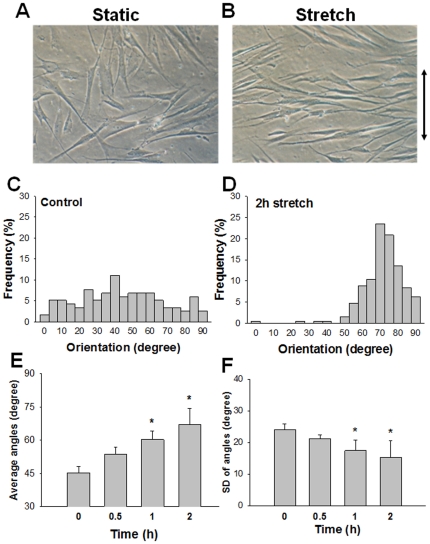
Effects of cyclic stretch on cell reorientation.Phase-contrast images of the cells in the static condition (A) or in response to cyclic stretch (20% in strain, 30 cycle/min) (B). An arrow indicates stretch direction. Histograms of the orientation response of the cells in the static condition (C) or to 2 h uniaxial cyclic stretch (D). Images of the unstretched and stretched cells were obtained at 0.5 h, 1 h, and 2 h after the onset of cell stretching. After the cell angles were measured, the angles were binned into 19 groups for every 5°: 0°, 1–5°, 6–10°, …, 81–85°, and 86–90° (C and D). Total cell number (frequency) was set as 100% and the frequency in each group was expressed relative to the total cell number. (E and F) The mean and standard deviation (SD) of the cell orientation at each time point. The decreasing SD of angles indicates that the cells were aligning in a direction which was almost perpendicular to the direction of applied stretch. Bar graph represents means ± SD (across 5 different trials). Data were analyzed with one-way repeated-measure ANOVA followed by the Bonferroni test. *: Significantly different (P<0.05) from the unstretched control (time 0) value (n = 5).